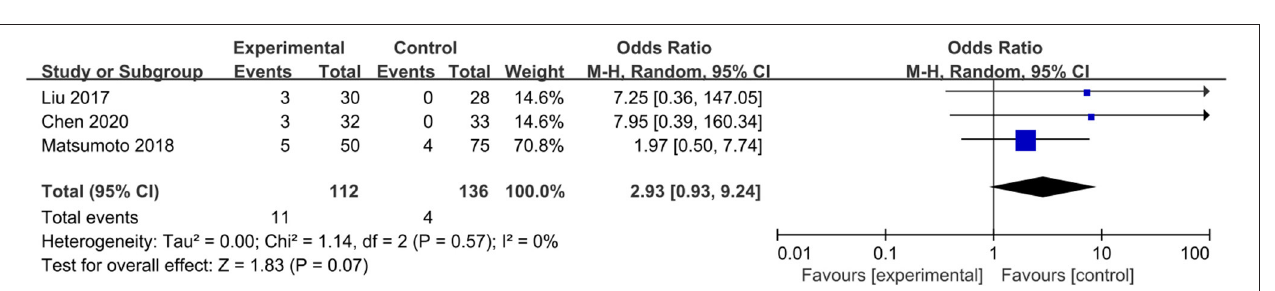
FIGURE 4 | Forest plot of rate of postoperative pulmonary complications comparing using electrocautery to